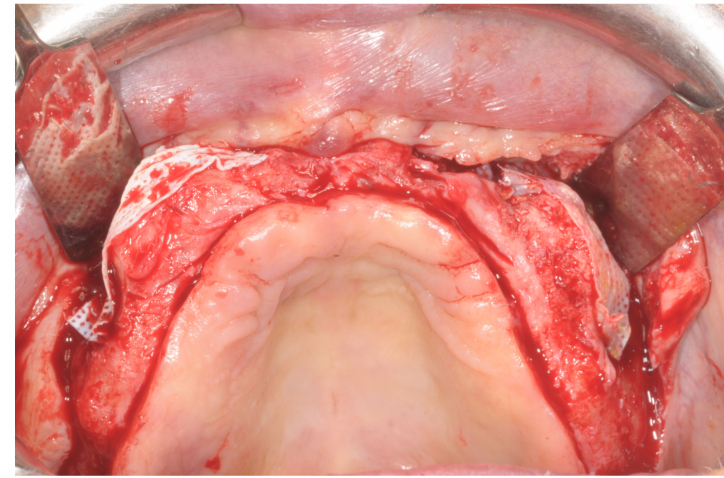
Figure 6. Surgical exposure of the augmented area 9 months after GBR.